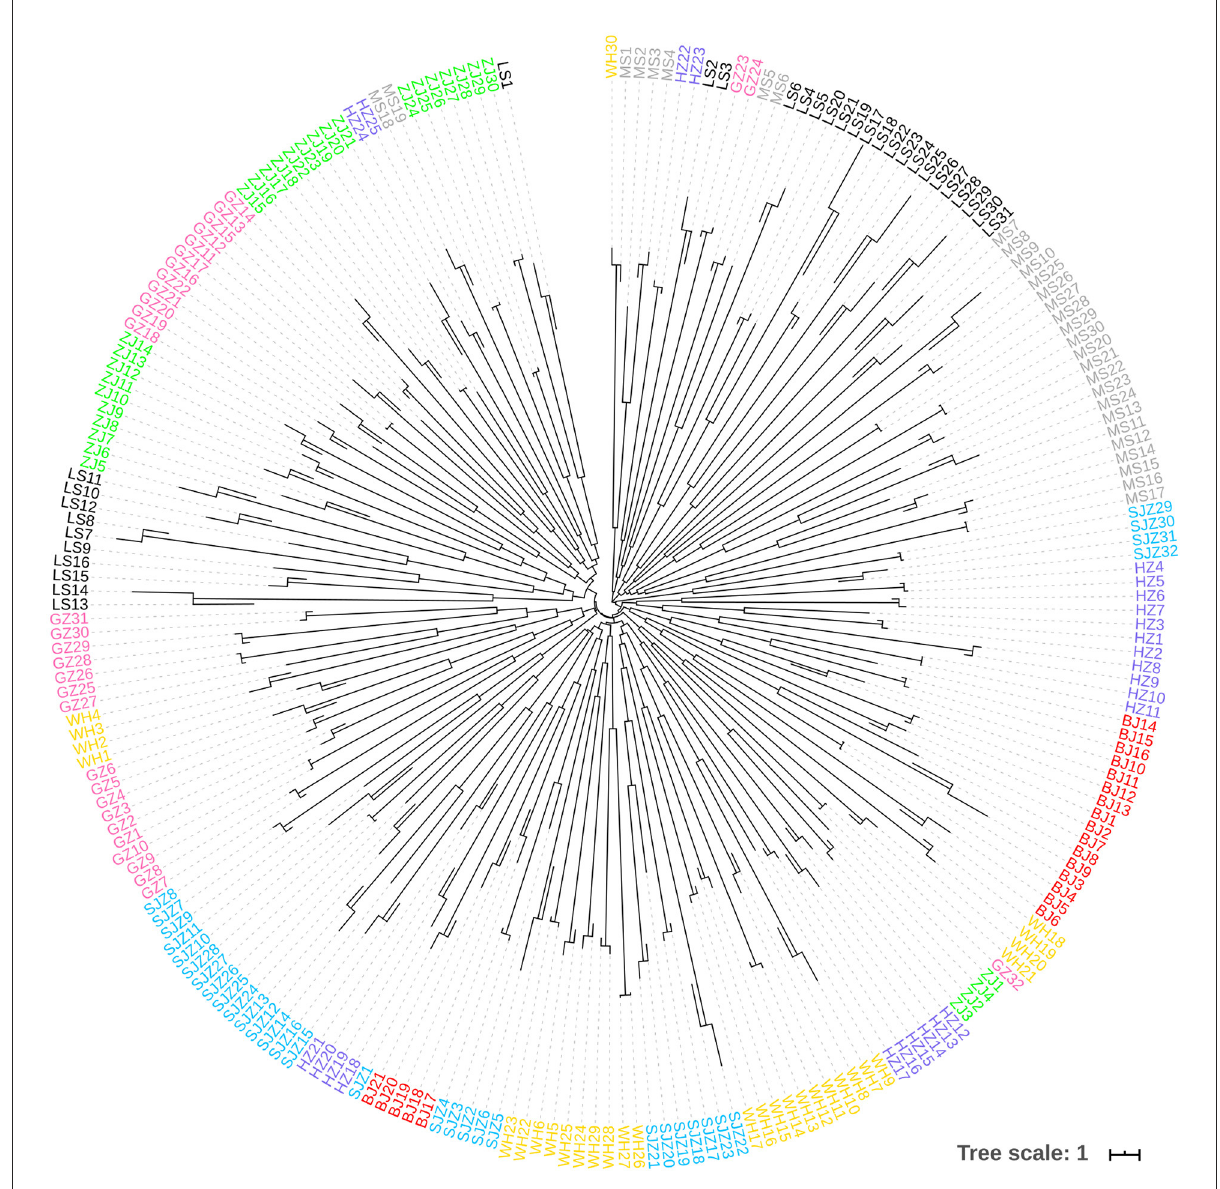
FIGURE6 Neighbor-Joining phylogenetic tree constructed using the microsatellite